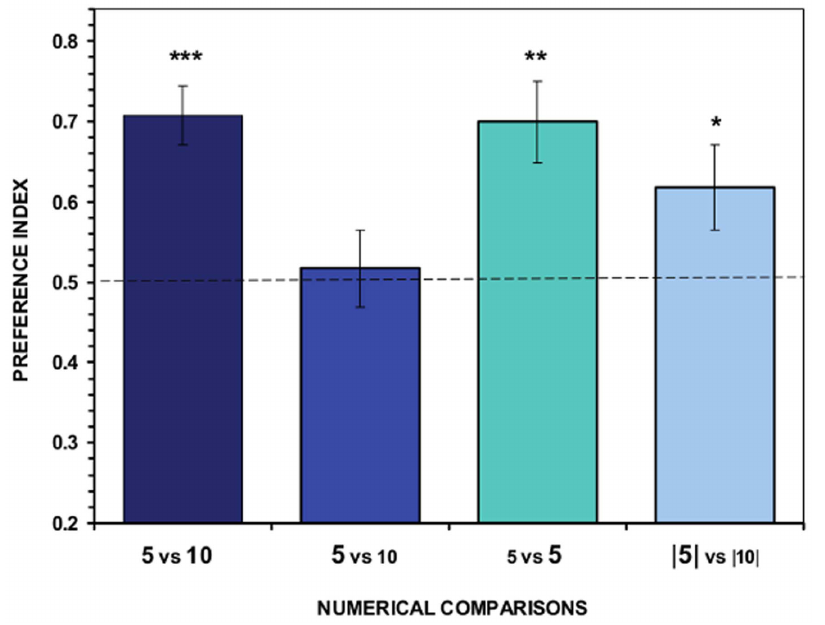
Figure 3. Results of Experiment 1. Proportion of time ( preference index , Mean 6 SEM) test fish spent in close proximity to the stimulus shoals. Values above 0.5 indicate a preference for the more numerous shoal of stimulus fish or a preference for the stimulus shoal with the greater overall surface area when the stimulus shoal is of the same numerical size. In the X-axis legend the numbers indicate the number of members of the contrasted shoals. We also illustrate the size of the body surface area: the large font size means that the body surface area of the stimulus fish was large and the smaller font size indicates that the surface area was small. Note that in case of the second condition (second bar) the total surface area of the two contrasted shoals was made similar by increasing the surface area of the individual stimulus fish in the less numerous shoal and decreasing it in the more numerous shoal. Numbers in between bars | | (fourth condition) represent stimulus shoals confined in small sectors of a transparent compartment which was designed to minimize differences in several continuous variables that may have covaried with the sizes of these shoals (see text for details). Significant departure from the null hypothesis of no shoal preference is indicated by asterisks: * P , 0.05; ** P , 0.01; *** P , 0.001.